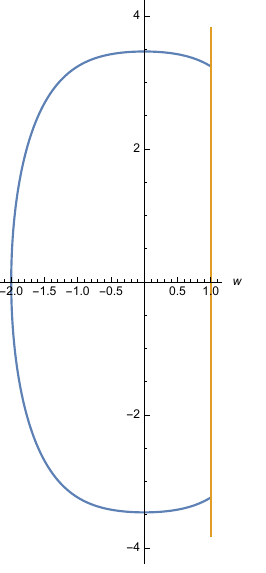
Figure 3. Impact solution of (25) and (26) for w 0 = −